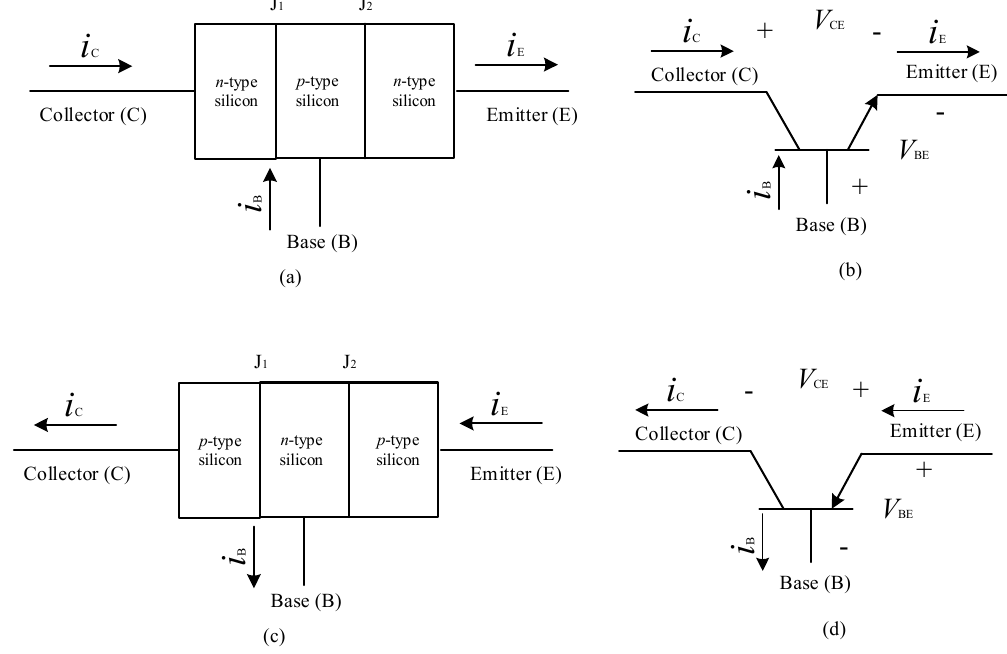
Figure 5. Structural diagram and schematic symbols of ( a , b ) an NPN transistor and ( c , d ) a PNP transistor [101].